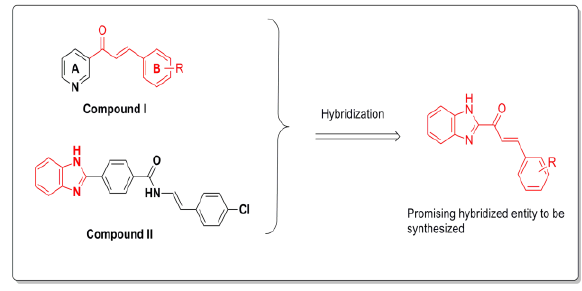
Fig. 3. The design strategy of the targeted compounds. The compound’s I derivatives have good MIC towards MRSA [17] . Compound II has a MIC of 12.5 µg/ml toward S. aureus and 100 µg/ml against E. coli [6] .